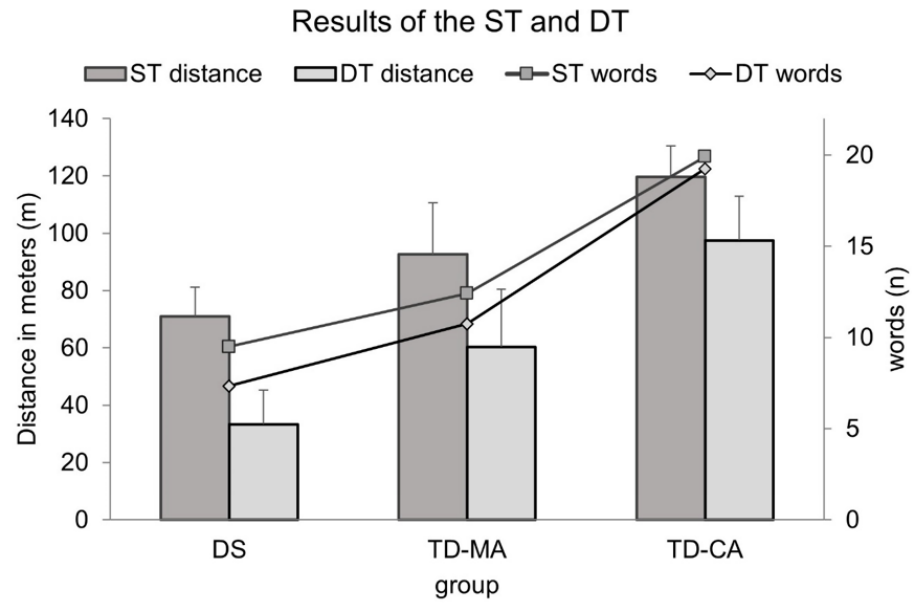
Figure 1. Results for the walking distance and the number of the recited animals for ST and DT conditions in DS, TD-MA, and TD-CA children. Note: DT = dual-task; ST = single-task; DS = Down Syndrome; TD-CA = typically developing children of the same chronological age; TD-MA = Typically developing children of the same mental age. 2 p = 0.430, and the DT 2 p = 0.577. The number of recited words in children with DS and TD-MA children did not differ under ST or DT condition ( p = 0.212), again with TD-CA children naming the largest number of words. 2 p = 0.121, but group differences were observed in motor DTC, 2 F (2,33) = 12.1, p < 0.001, p = 0.424. Children with DS differed significantly from TD-CA children ( p < 0.001) and tended to differ significantly from TD-MA children ( p = 0.05). Thus, significantly higher cognitive DTC were observed for children with DS. TD-MA and TD-CA children only tended to differ from each other without statistical significance ( p = 0.065) (Figure